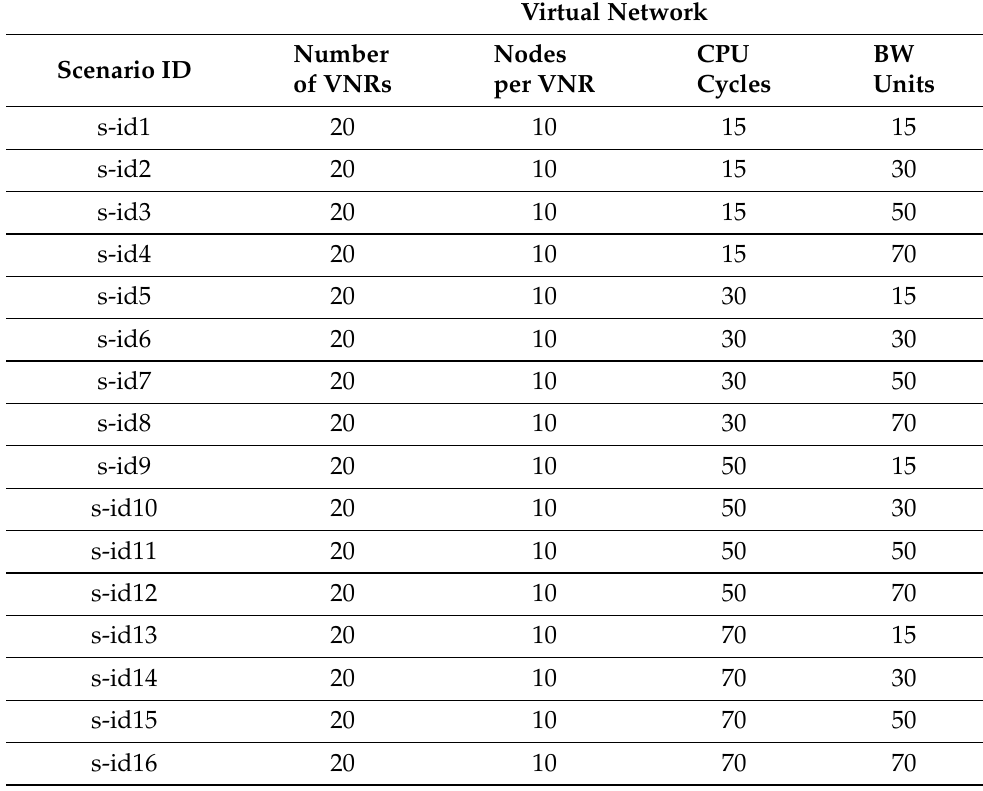
Table 5. The few–large parameter